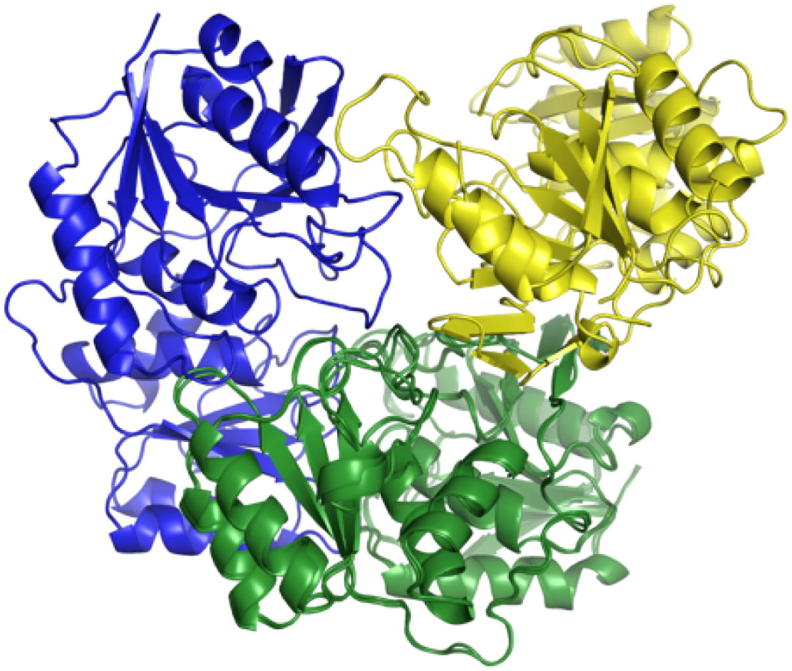
Superimposition on the chain A (in green) of the best structural configurations in the second run (in yellow) and in the first run (in blue). (For interpretation of the references to colour in this figure legend, the reader is referred to the web version of this article.)